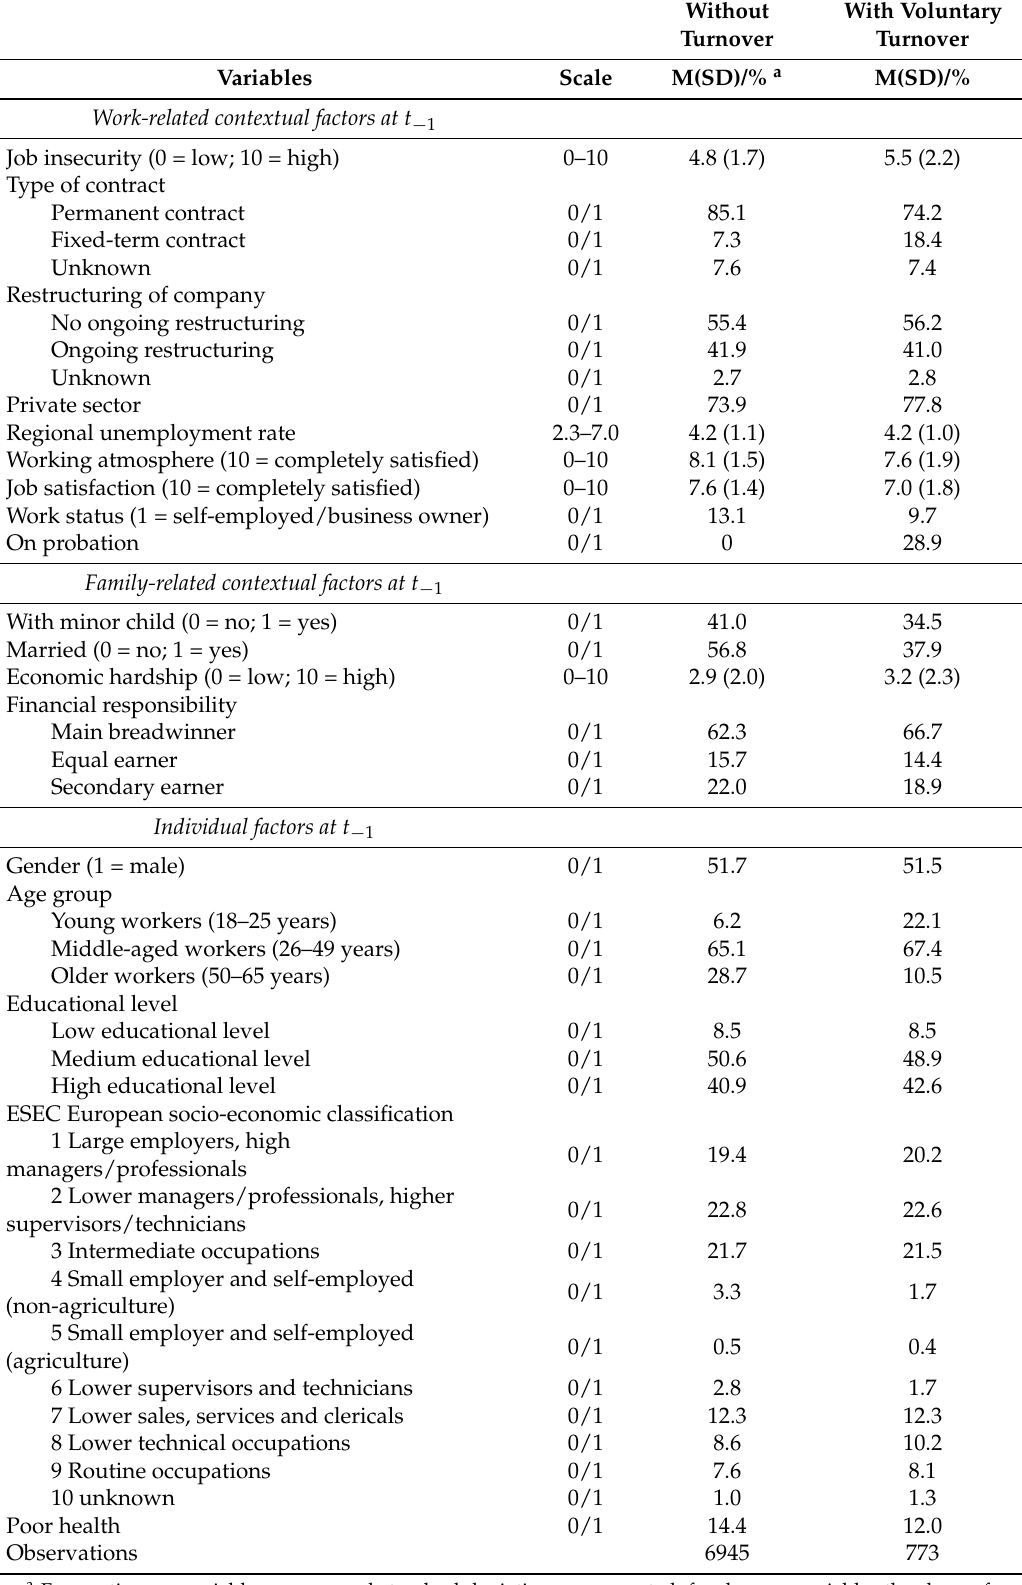
Table 1. Descriptive statistics before PSM is applied, based on observations and separated by employees without and with voluntary turnover. Data is not